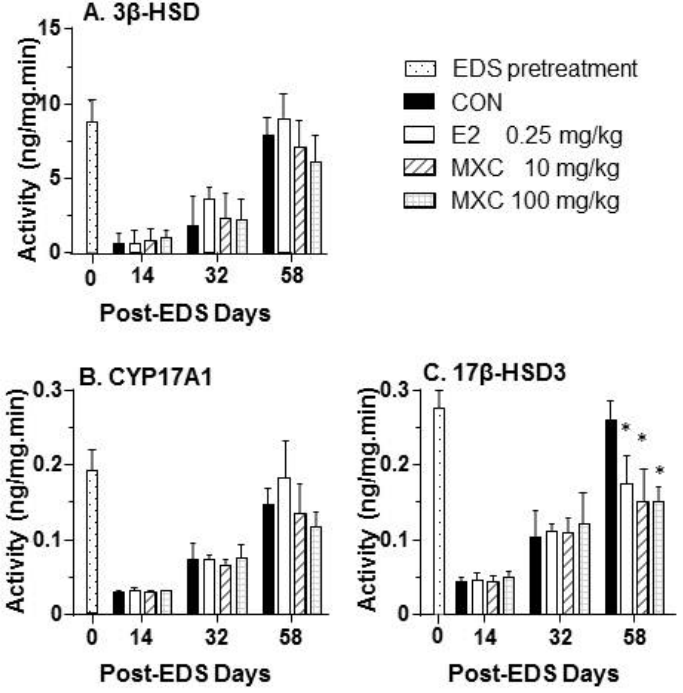
Figure 6. Steroidogenic enzyme activities of testis after estradiol (E2) and methoxychlor (MXC). ( A ) 3 β -HSD; ( B ) CYP17A1; ( C ) 17 β -HSD3. Mean ± SEM, n = 5. * indicates significant difference when compared to the control (CON) at each time point at p < 0.05.